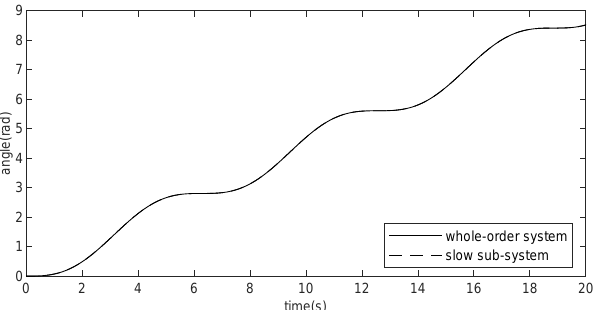
Figure 1. Position curves of the original system and the slow